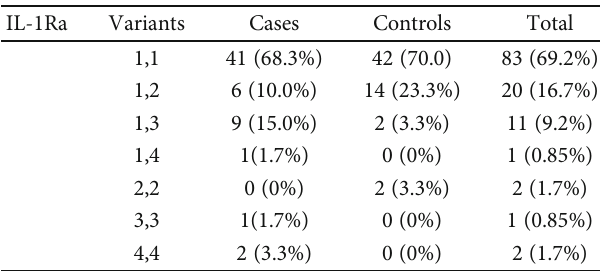
Table 2: Possible IL-1Ra genetic polymorphism variants seen among patients and controls.